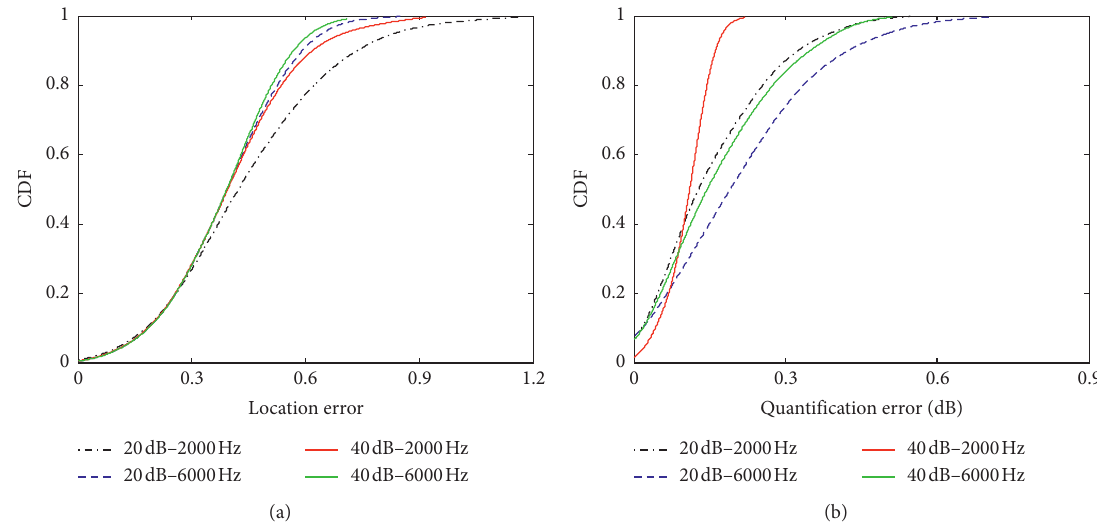
Figure 7: Cumulative distribution function for error of SFISTA under 200 trials of Monte Carlo simulations. (a) Location error; (b) quantification error.